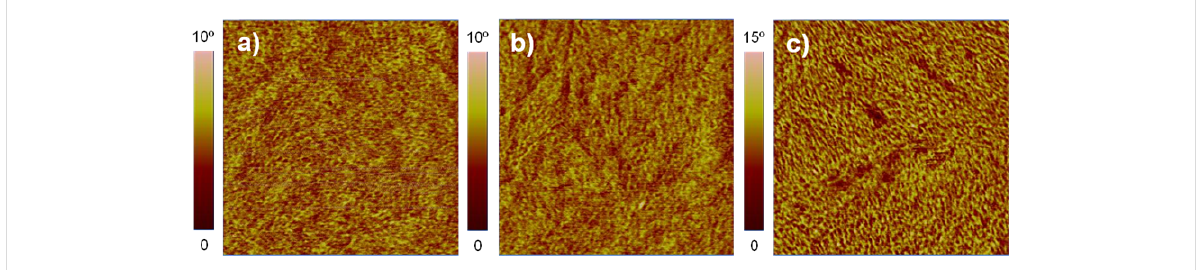
Figure 6: AFM phase images of samples spin-coated on ITO|PEDOT:PSS| with (a) DCV5T-Bu 4 :PC 61 BM from CB, (b) DCV5T-Bu 4 :PC 61 BM from CB:CN (0.375%), and (c) DCV5T-Bu 4 :PC 71 BM from ODCB. Image size: 1 × 1 μ m.